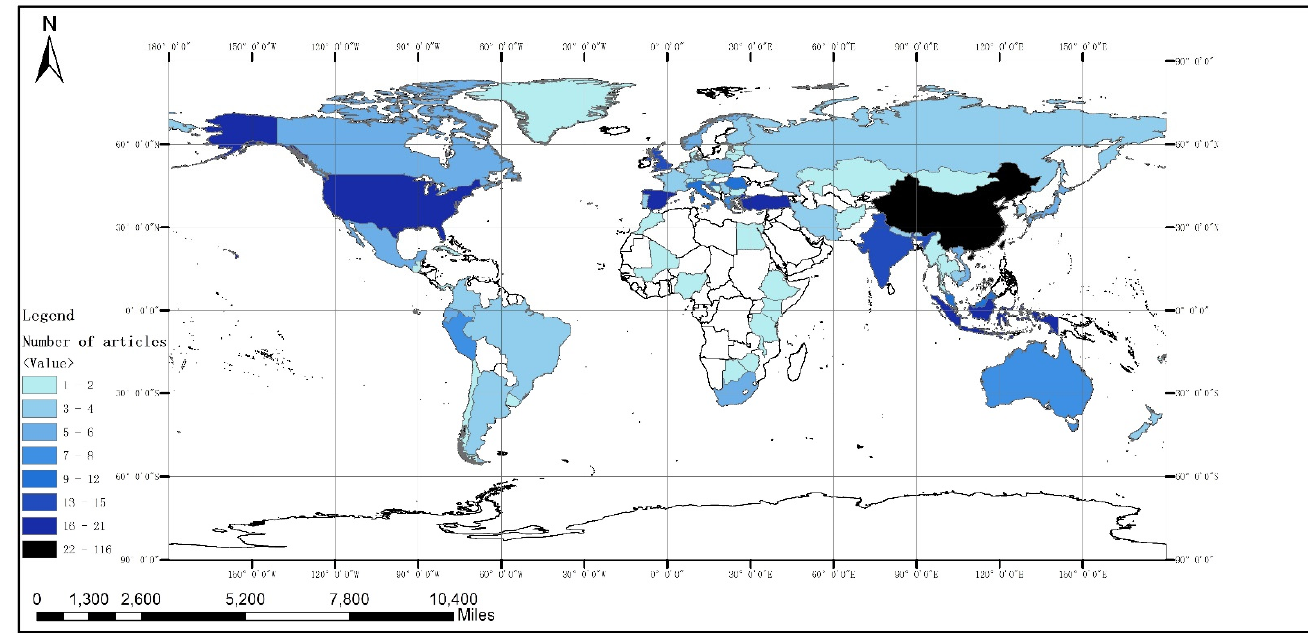
Figure 4. Country distribution of collected papers from WOS. Source: edited by authors based on research and ArcGIS output.